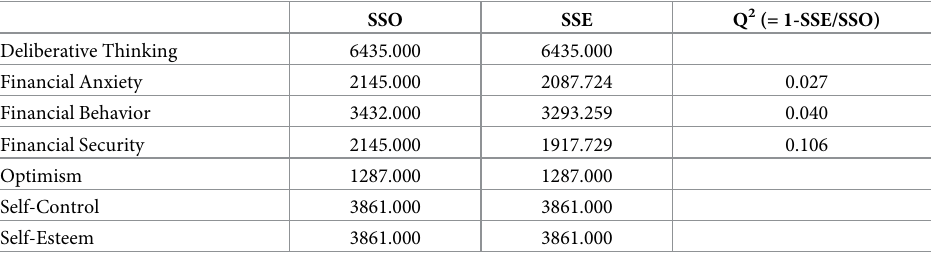
Table 6. Blindfolding and predictive relevance (Q 2 ) of